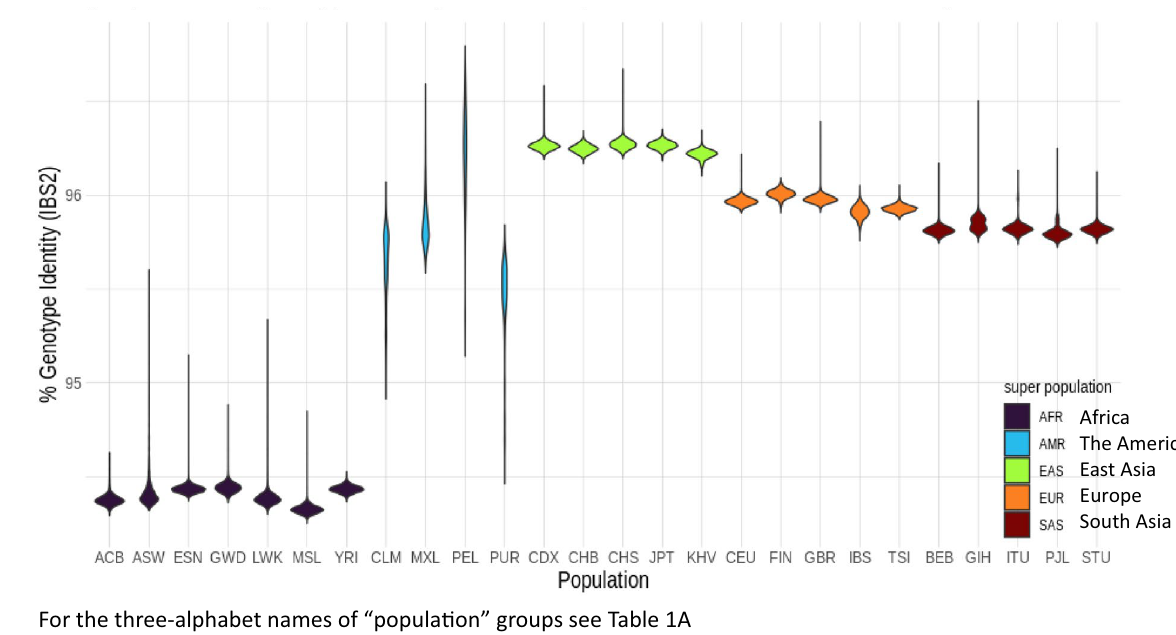
For the three-alphabet names of “popula(cid:7)on” groups see Table 1A